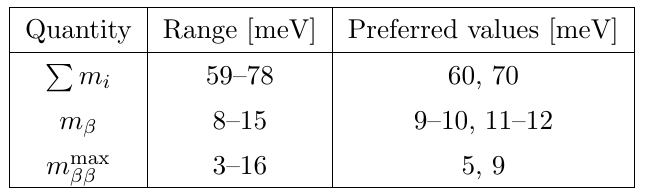
Table 12 . Range of predictions for P m i , m (cid:12) and m (cid:12)(cid:12) scanning over (cid:12)ts with (cid:31) 2 < 20 and (cid:31) 2 < 20. The last column indicates the values preferred by most (cid:12)ts. O (1) including them would make the (cid:12)t only better). The (cid:12)t results are shown in table 10, and include also the e(cid:11)ective suppression scale M of Weinberg operator, which is of the order of 10 11 GeV. The (cid:12)t is even better compared to Dirac Neutrinos (cf. table 6), with all O (1) parameters roughly between 0.4 and